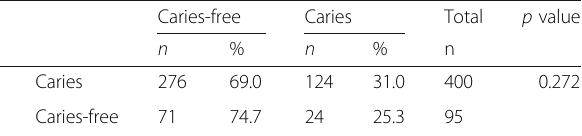
Table 3 Characteristics, dental condition, caregivers status and caries at follow-up ( n = 566)